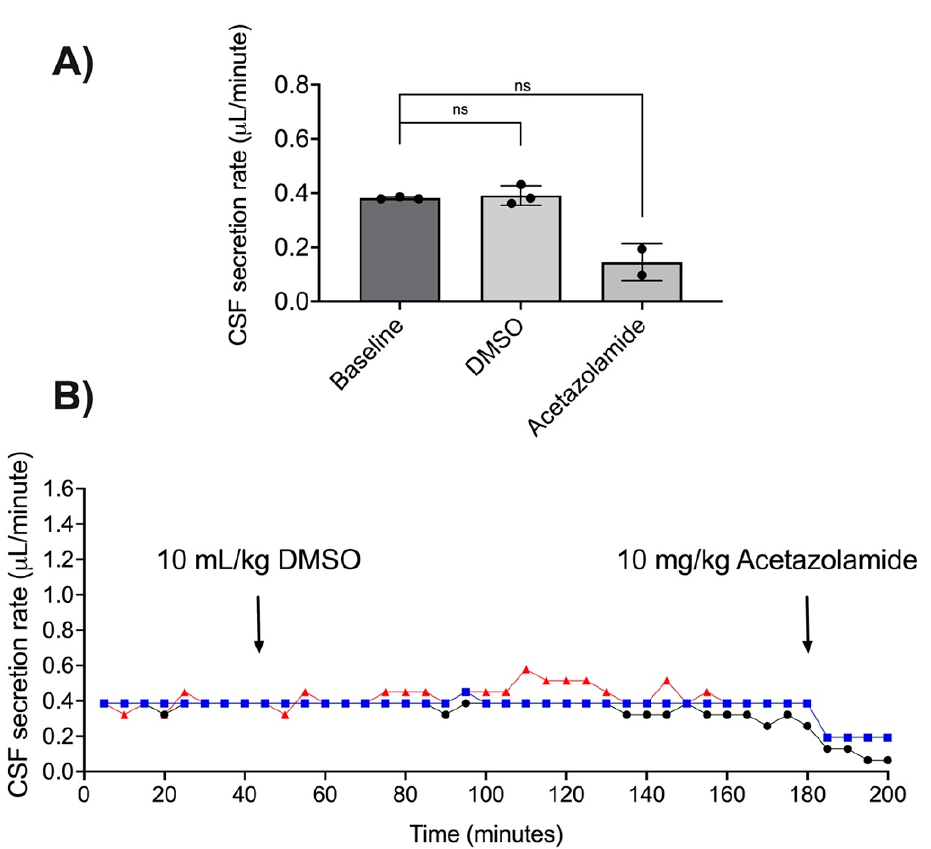
Figure 4. Effects of dimethyl sulfoxide (DMSO) on cerebrospinal fluid (CSF) secretion. ( A ) CSF secretion rate (mean ± SD; µ L/min) for all animals at baseline, after administration of DMSO, and after administration of acetazolamide. Points represent individual animals. ( B ) Individual CSF secretion rate plots over time in response to DMSO and acetazolamide. Symbols and colours are distinct for each animal. ns = no significant difference, Student’s t-test compared with baseline.